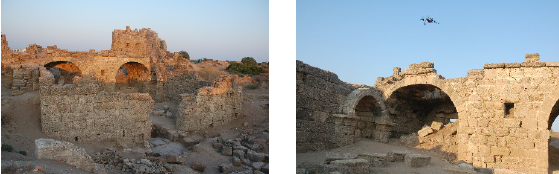
Figure 6: Image acquisition with an AscTec Falcon 8